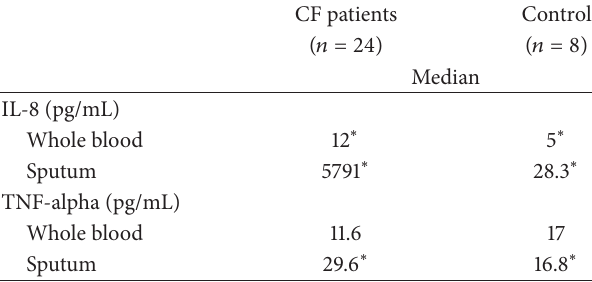
Table 3: IL-8 and TNF-alpha in whole blood and sputum.